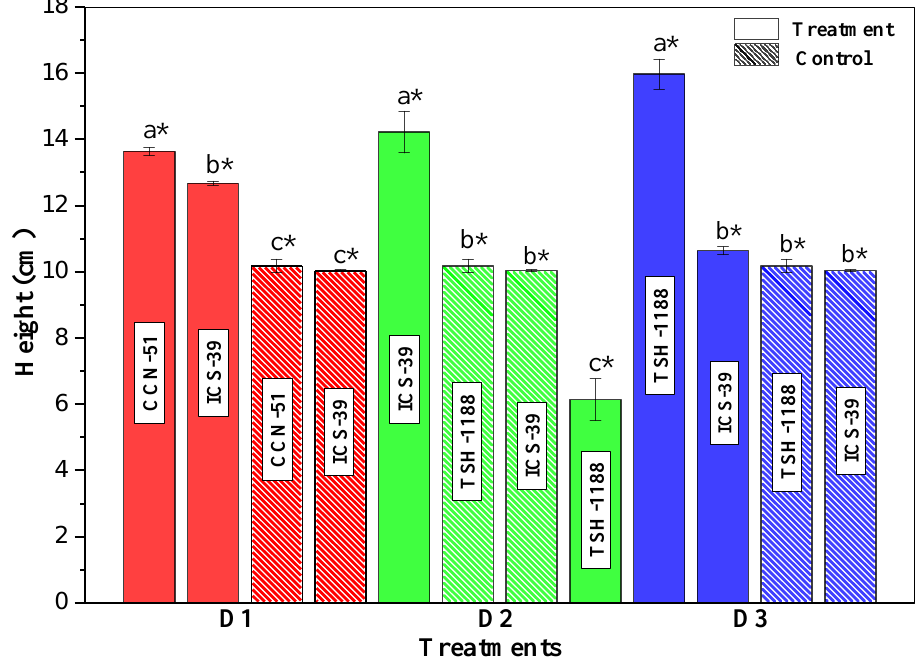
Figure 9. Mean heights for the different zeolite 5A treatments applied to the different genotypes with respect to a seedling contaminated only with Ni +2 : (a) red 1 g zeolite, (b) green 2 g zeolite, and (c) blue 4 g zeolite. We can note that the D3 treatment for G3 for the height variable resulted in reaching the greatest height compared to the other treatments. * p < 0.05. a, b, c, and d denote the groups that had statistical significance among themselves, within each treatment. groups that had statistical significance among themselves, within each